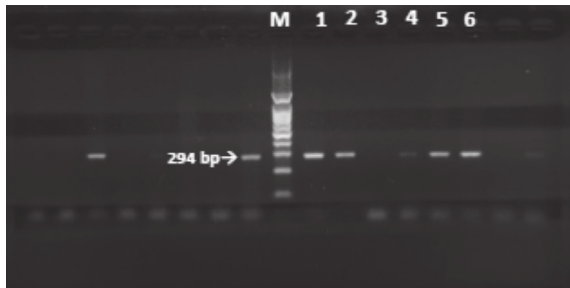
Figure 7: PCR amplification of UreC ( glmM ) for H. pylori de- tection: M: 100 bp ladder; lanes 1, 2, and 4–6: positive (at 294bp); lane 3: